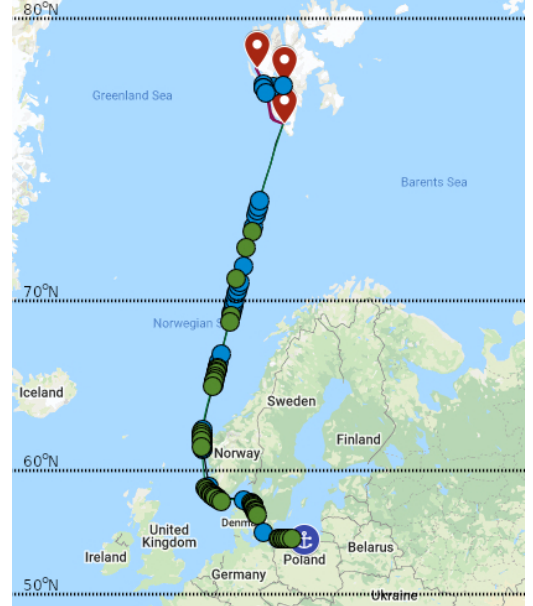
Figure 1. Cruise logs of the MS Horyzont II during the Gdynia-Spitsbergen cruise (and back) in the period 2–21 July 2017 (days 183–202). Points (blue—cruise to Spitsbergen, green—cruise to Gdynia) show sites with the UV index (UVI) measurements. The disembarking ports are marked by red map pointers. The map was created with Google Maps software.